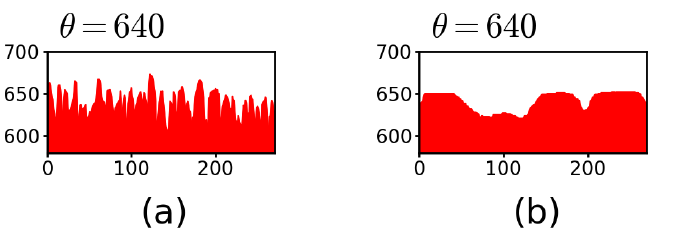
Figure 6. Vertical cross-sections of the deposits grown with parameter sets ( a ) C and ( b ) C2. All lengths are in units of the lattice constant.